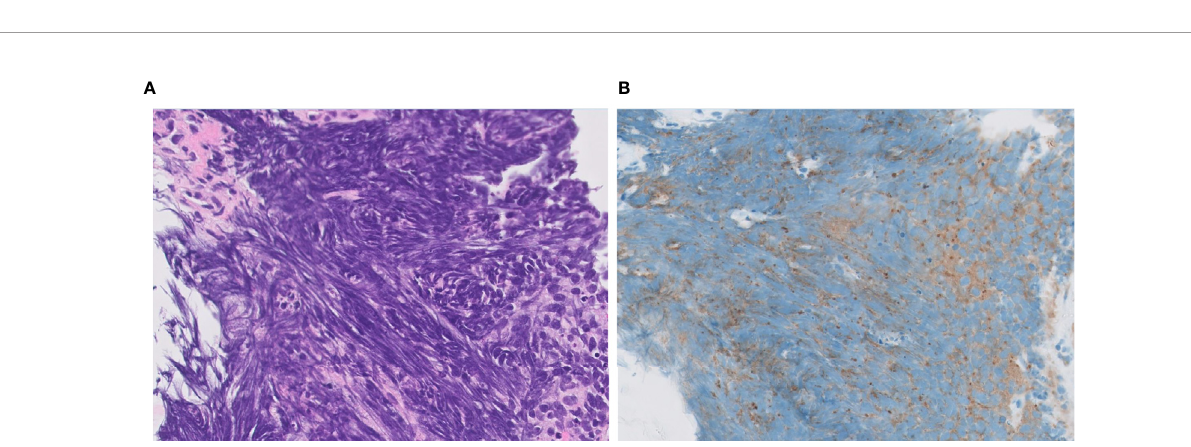
FIGURE 4 | Extensive crush artifact in small cell lung carcinoma. SCLC is often crushed during biopsy, which affects appearance on routine staining ( A , H&E) and immunohistochemistry ( B , synaptophysin). Magni fi cation: